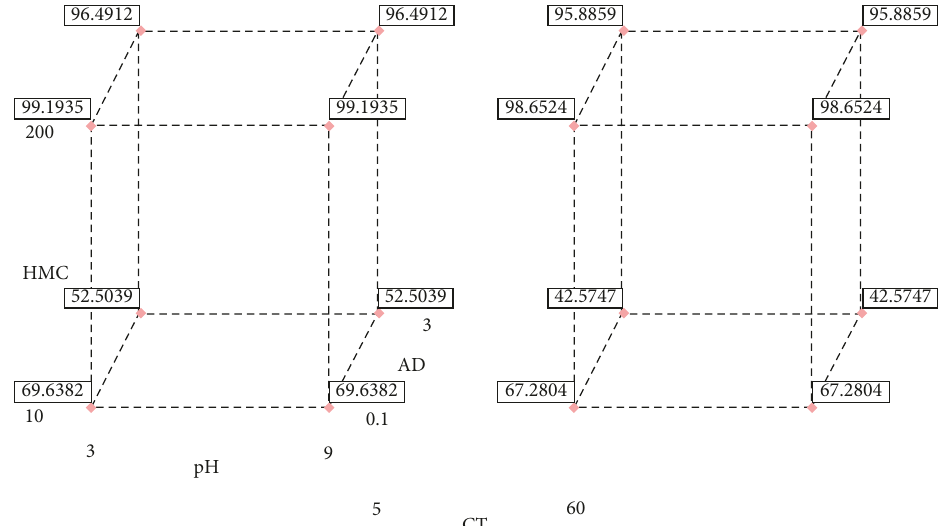
Figure 4: Cube plots for the model terms and